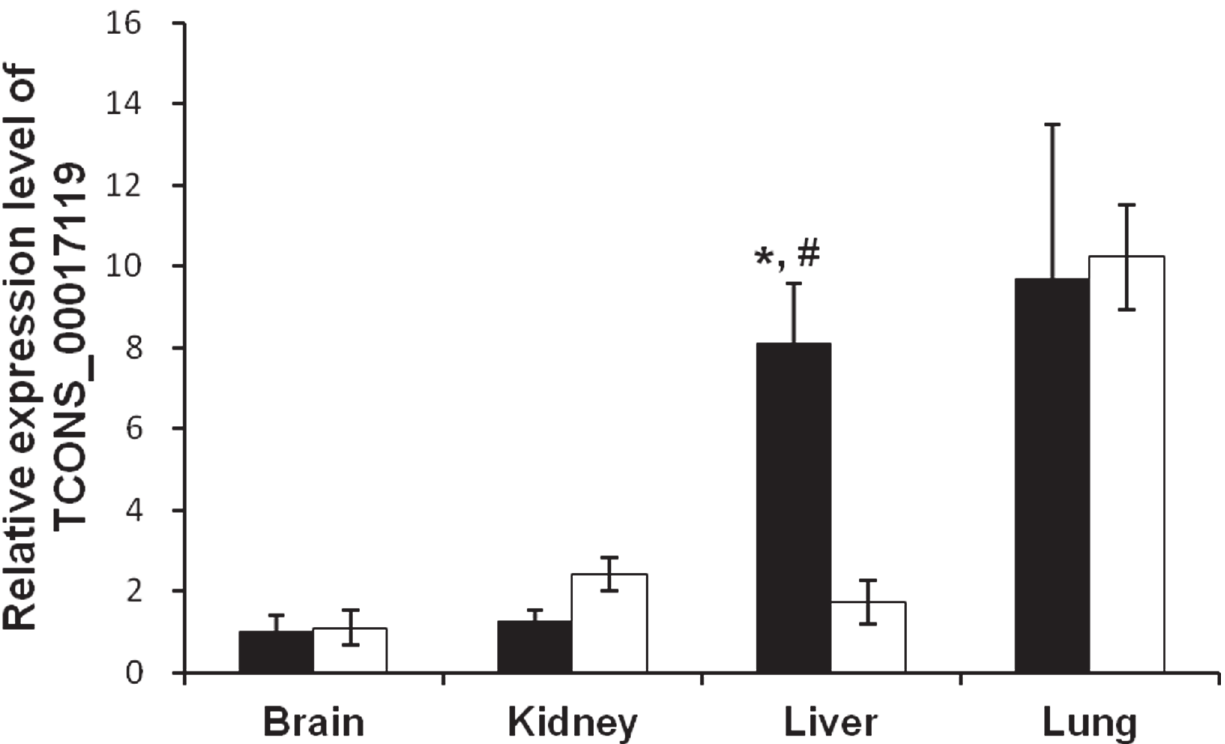
Fig 6. Comparison of lncRNA expression in different tissues. Comparison of the expression of lncRNA TCONS_00017119 in different tissues from low birth weight and control rats at postnatal day 10 by quantitative real-time PCR. The level of lncRNA was calculated relative to GAPDH. The data are expressed as relative to lncRNA level in the brain of normal control rats. Values are means with SEM. p Value was calculated by the Student ’ s t-test. Black bars, control rats (n = 5); open bars, low birth weight rats (n = 5). * p < 0.05 vs. low birth weight rats, # p < 0.05 vs. normal kidney.